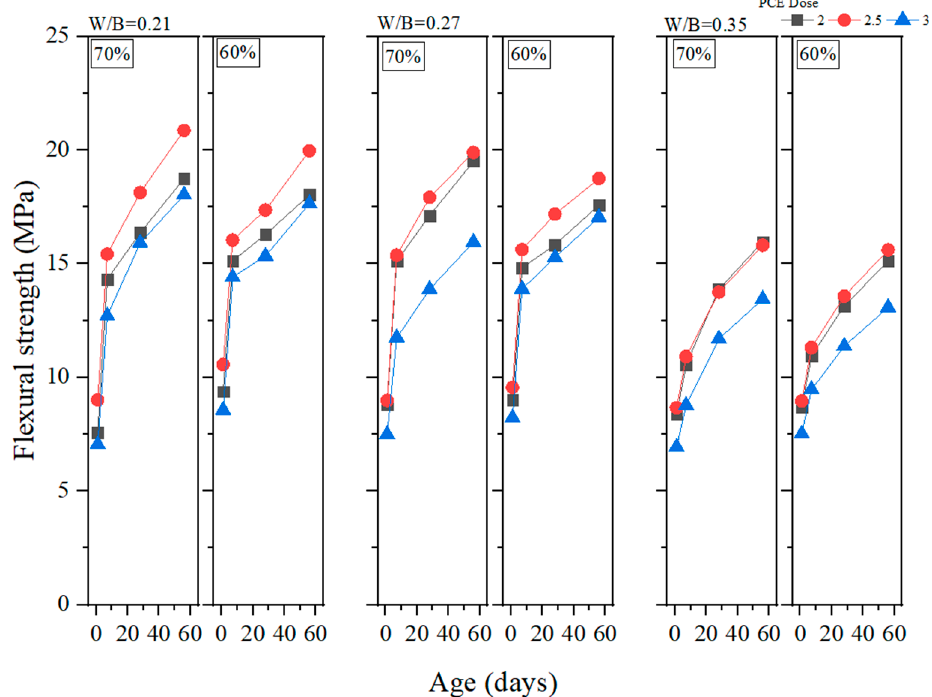
Figure 12. Flexural strength of green and ecofriendly grouting material with PCE.